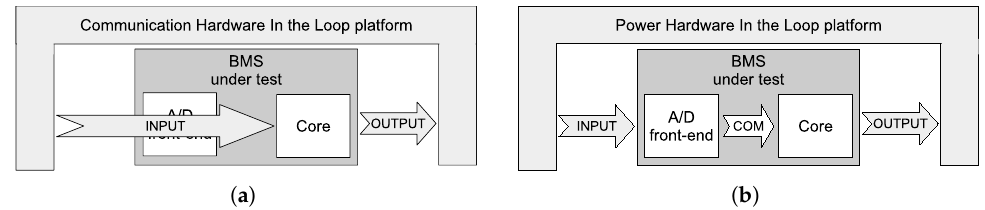
Figure 1. Block diagram of a general Hardware-In-the-Loop architecture based on Communication ( a ) and Power ( b )